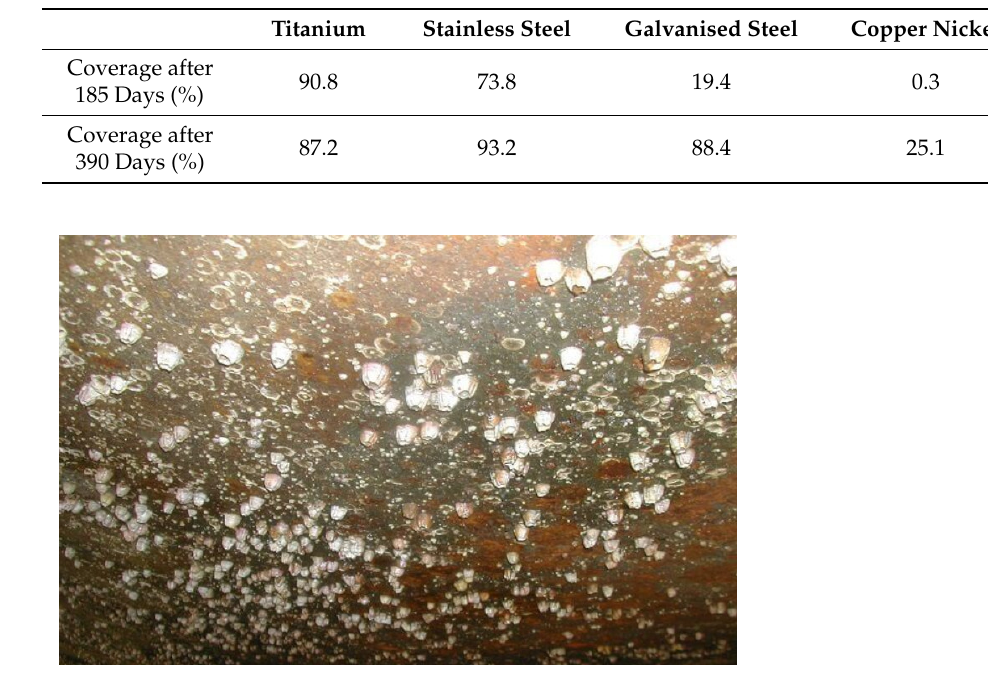
Figure 8. A photo on partial coverage by a colony of barnacles on a biofouled surface (https://www.marineinsight.com accessed on 25 February 2022).